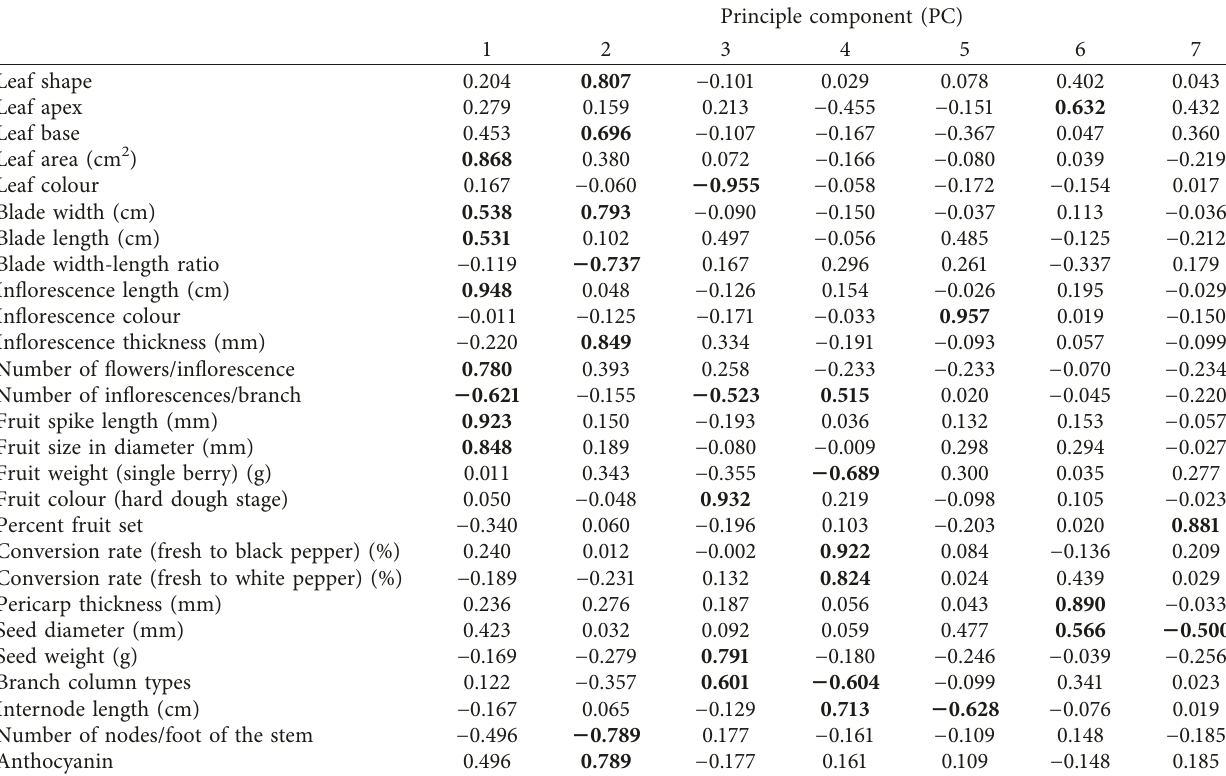
T ABLE 5: Matrix component value for all the distinguishing